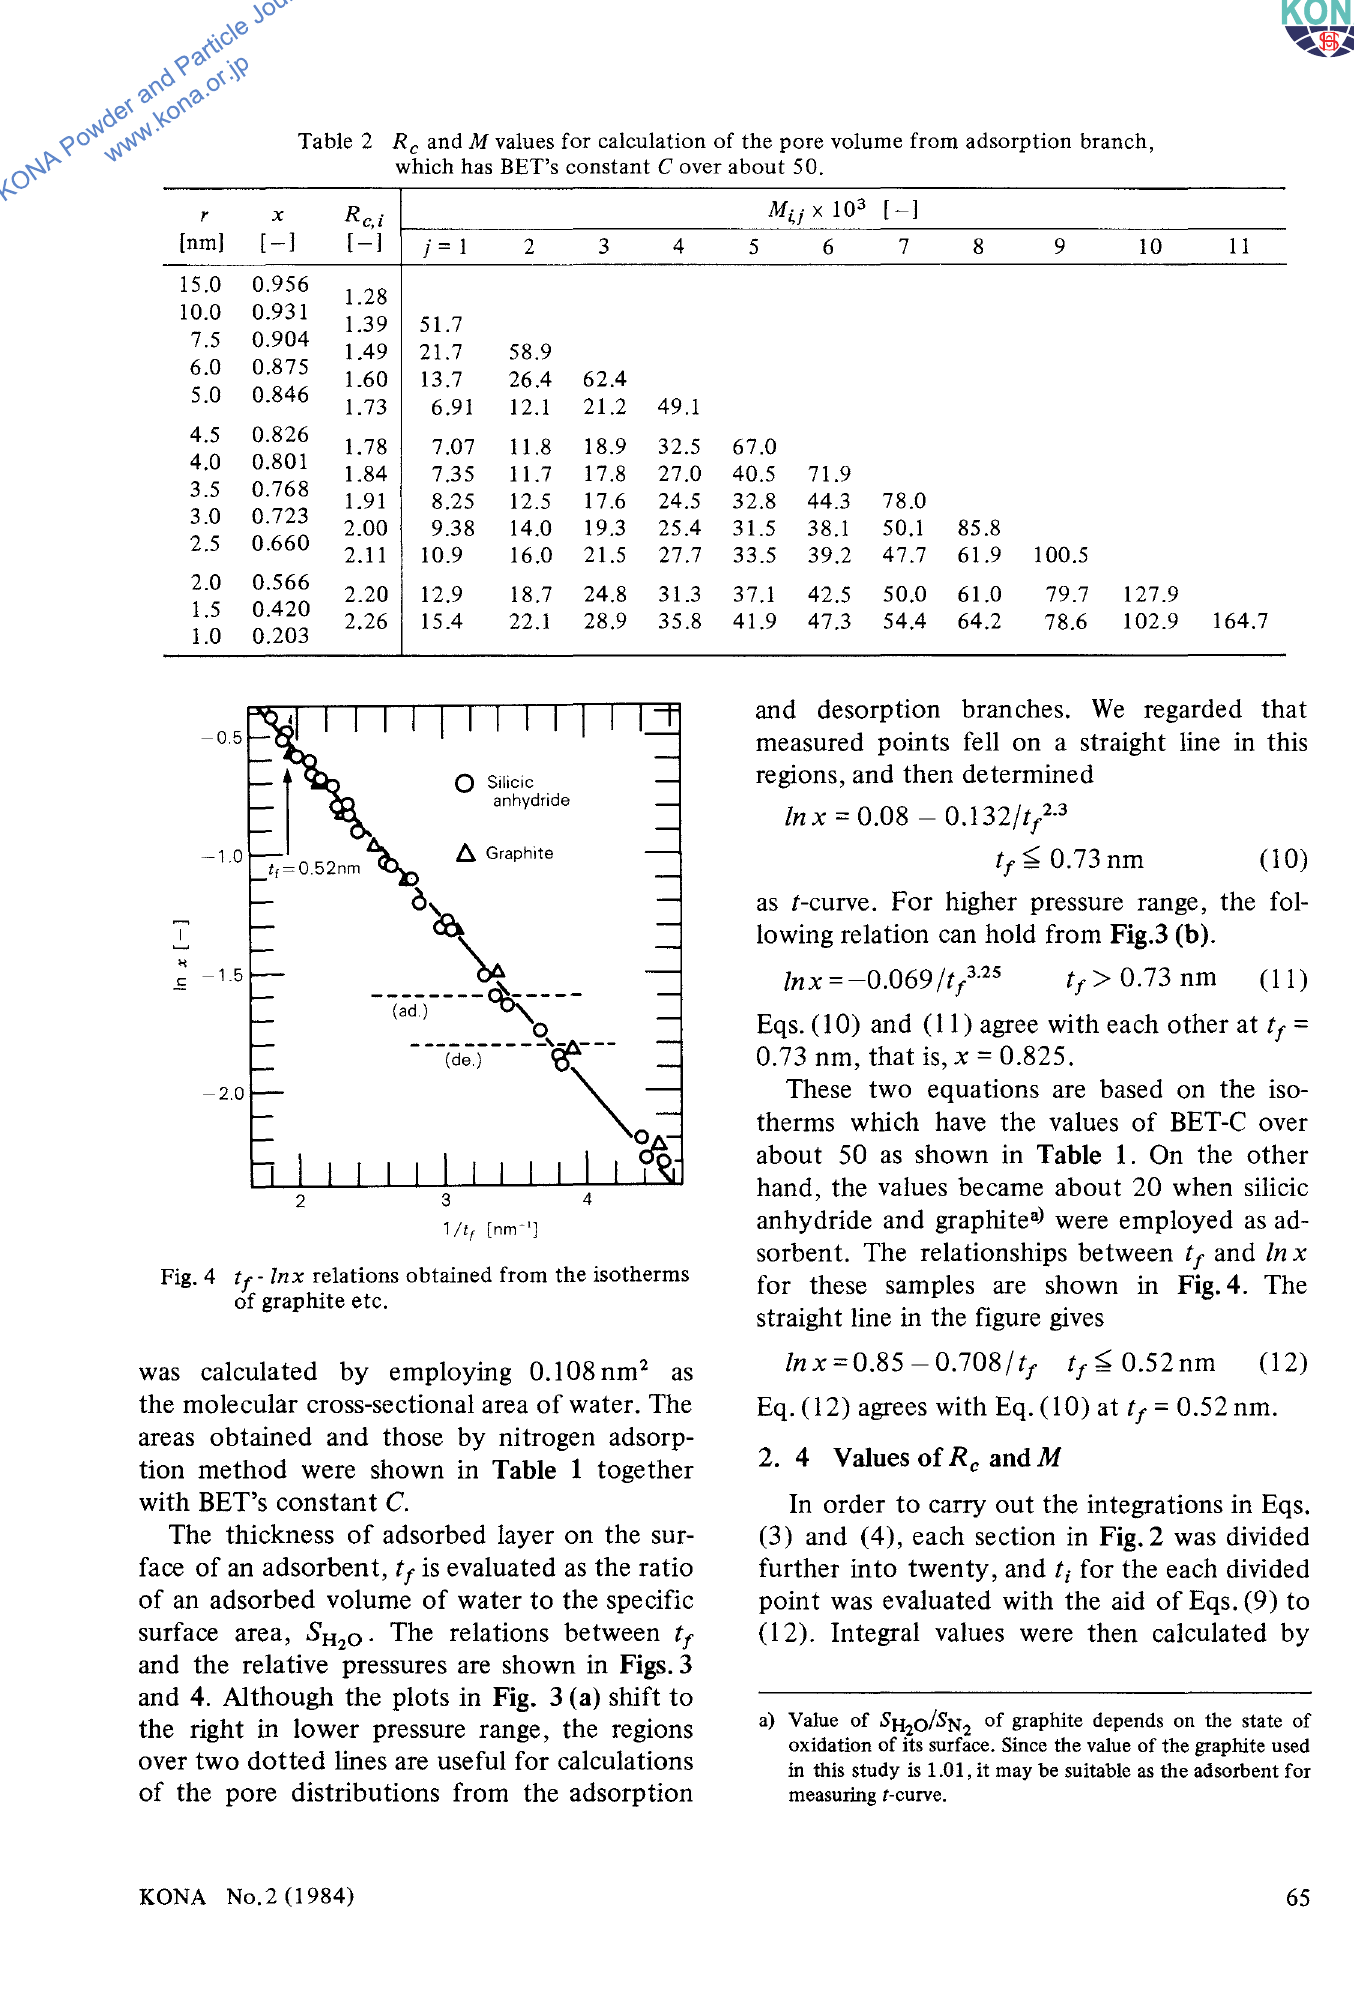
Table 2 Rc and M values for calculation of the pore volume from adsorption branch, which has BET's constant Cover about 50.